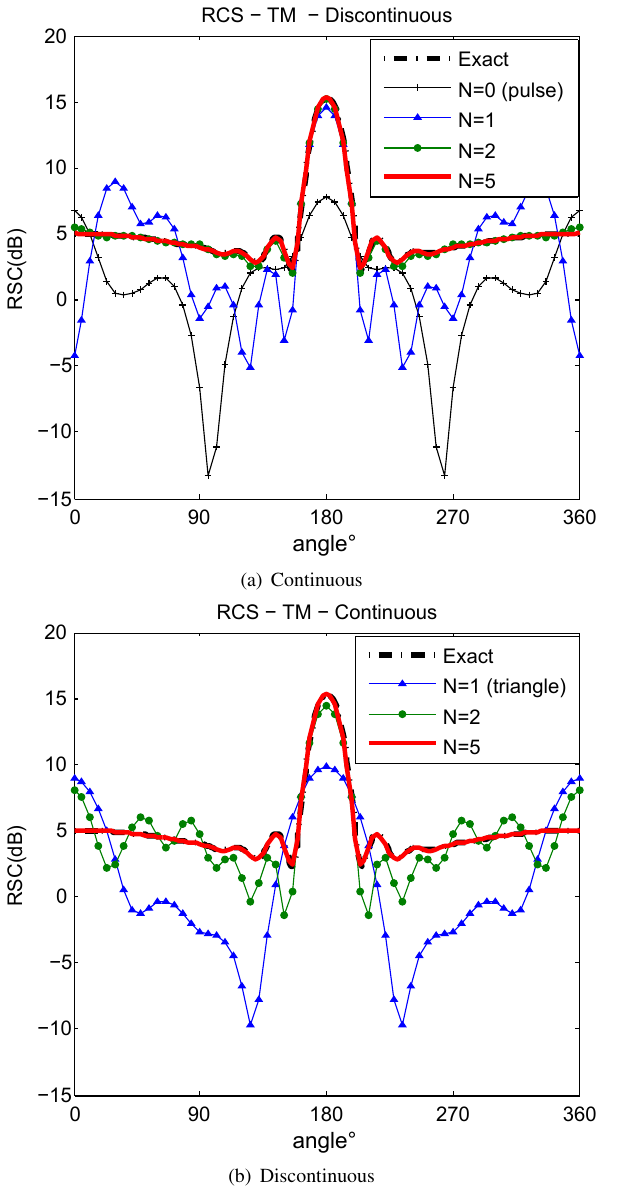
Figure 14: (TE polarization) RCS estimation with different orders for r = λ , L =